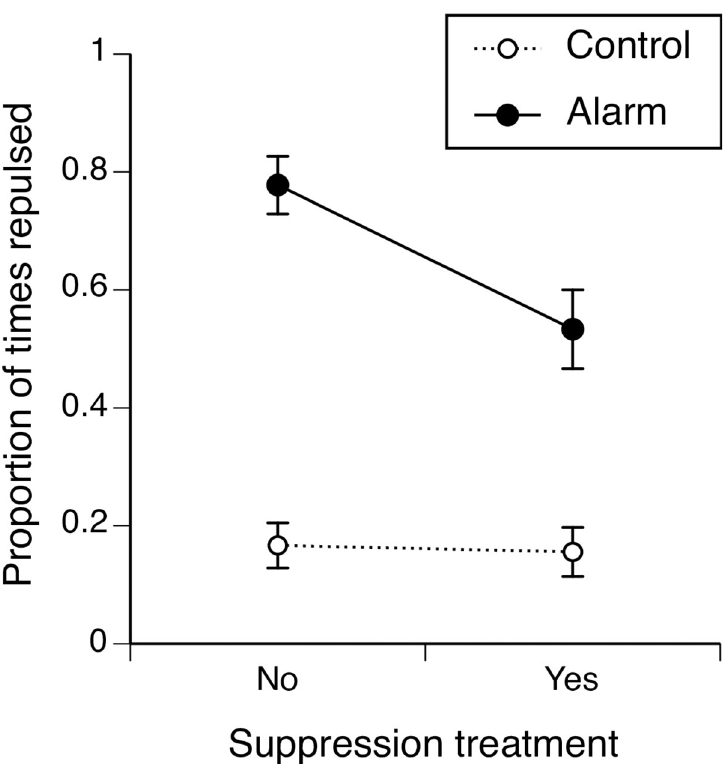
Fig 2. The proportion of times non-suppressed and suppressed cane toad tadpoles ( Rhinella marina ) exhibited a repulsion response when encountering either unchlorinated bore water or conspecific alarm cue (n = 30). Suppression-treated tadpoles were exposed to older conspecifics for 48 h during larval development. The graph shows mean values ±